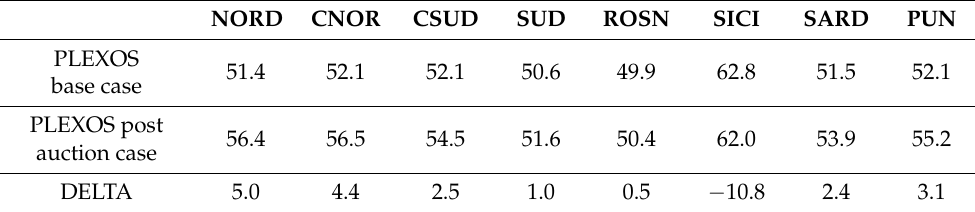
Table 4. Zonal prices and PUN of the Plexos base simulation compared to the post-auction one.